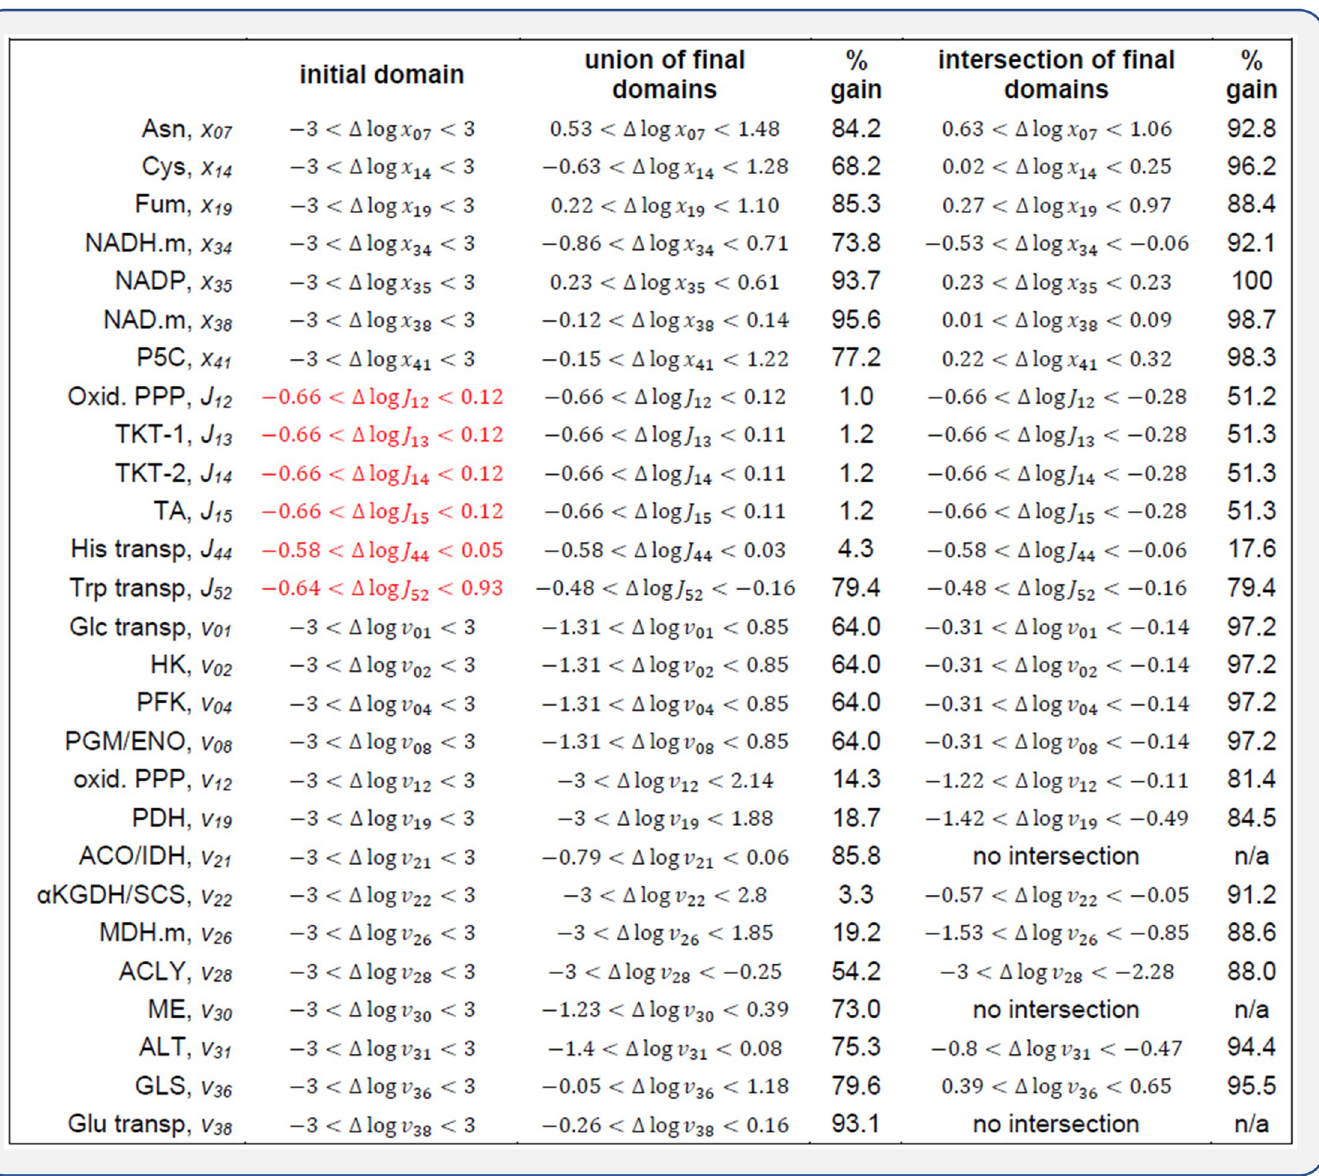
Fig 5. A numerical summary of the final domains. Cancer-case study. Interval unions and interval intersections of the ensemble of final domains for each variable in Fig 4. All logarithms are to base two.